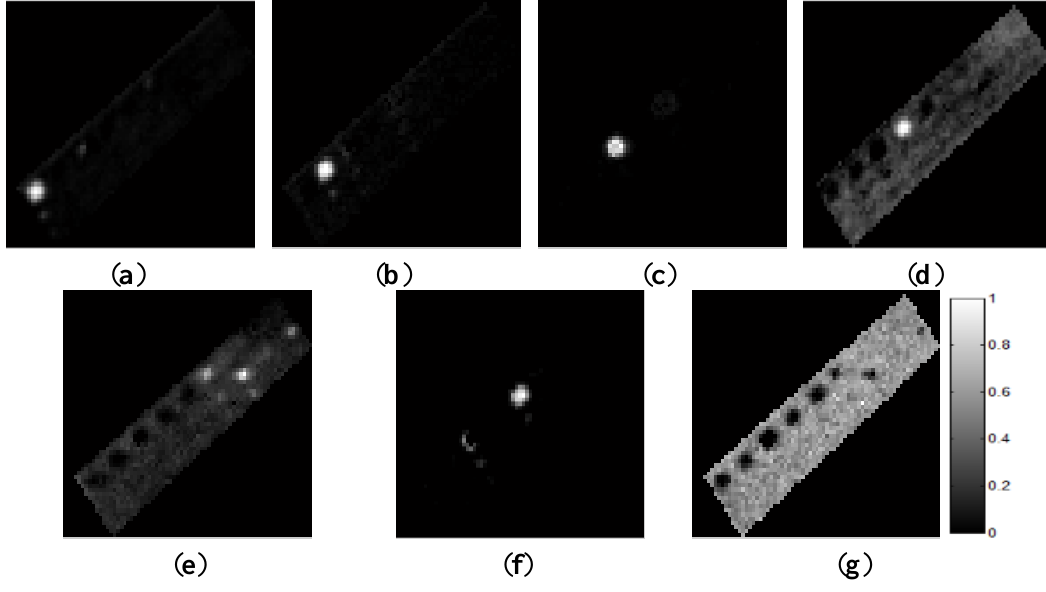
Figure 10. Abundance maps of the final endmembers in the AISA dataset obtained using RN-FINDR. ( a ) 𝐸